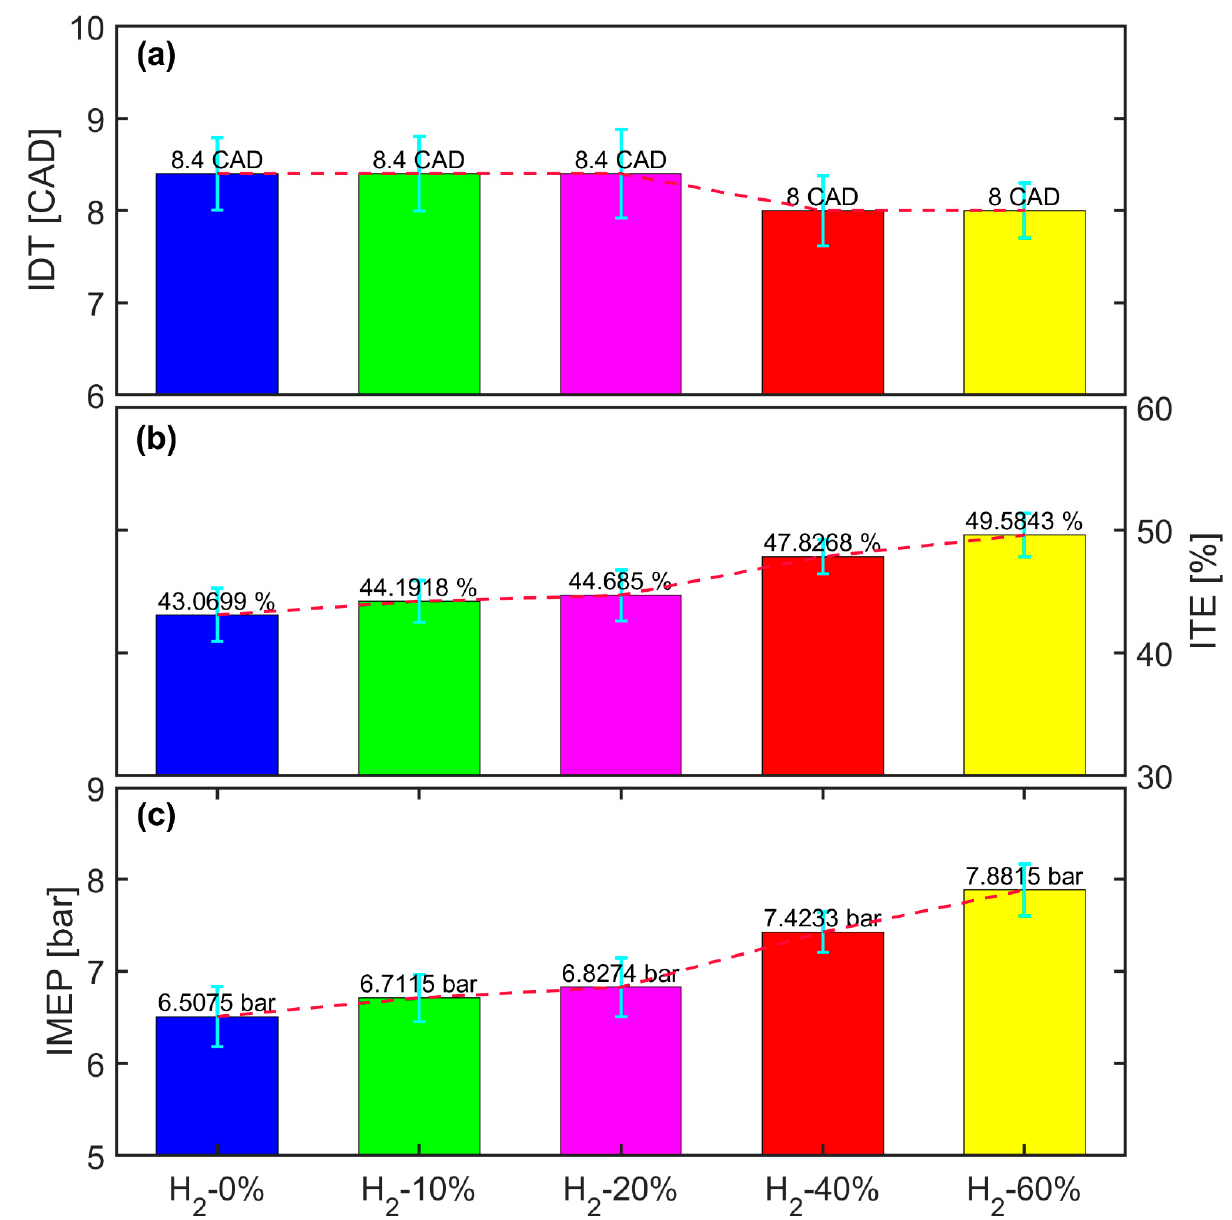
Figure 6. A summary of the effect of H 2 addition on TF combustion. ( a ) IDT, ( b ) ITE, ( c )